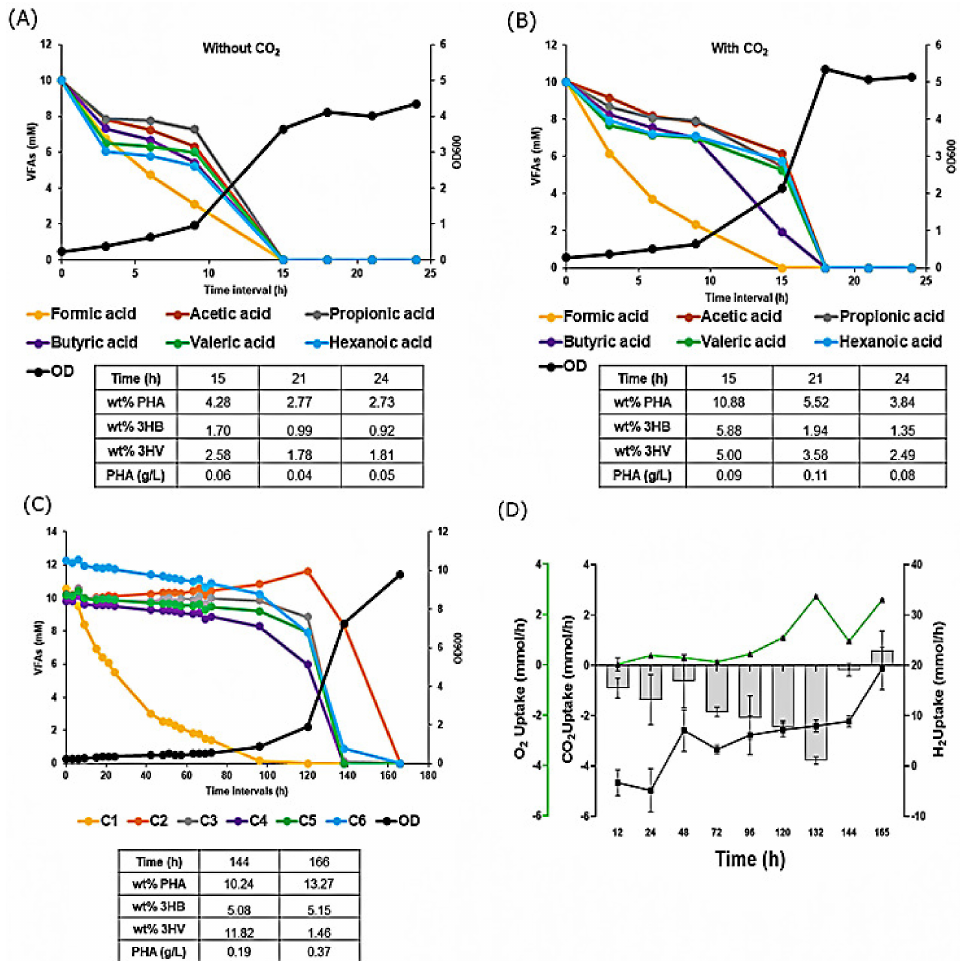
Figure 2. VFA utilisation and PHA production by C. necator H16 cultures grown in a bioreactor. VFA was fed to the reactor as a mixture. Panel ( A ) cultures grown with VFAs without CO 2 as an additional source of carbon; Panel ( B ) cultures grown with VFAs and with CO 2 as an additional source of carbon; Panel ( C ) cultures grown with VFAs and with CO 2 and H 2 as additional sources of carbon and energy. Panel ( D ) shows CO 2 and H 2 gas consumption by C. necator H16 cultures grown with CO 2 and H 2 as additional sources of carbon and energy. CO 2 uptake—grey bars, H 2 uptake—black line and O 2 uptake—green line. The wt% in g/gCDW of PHA and PHA yields are presented in the tables below for each growth condition, below Panels ( A – C